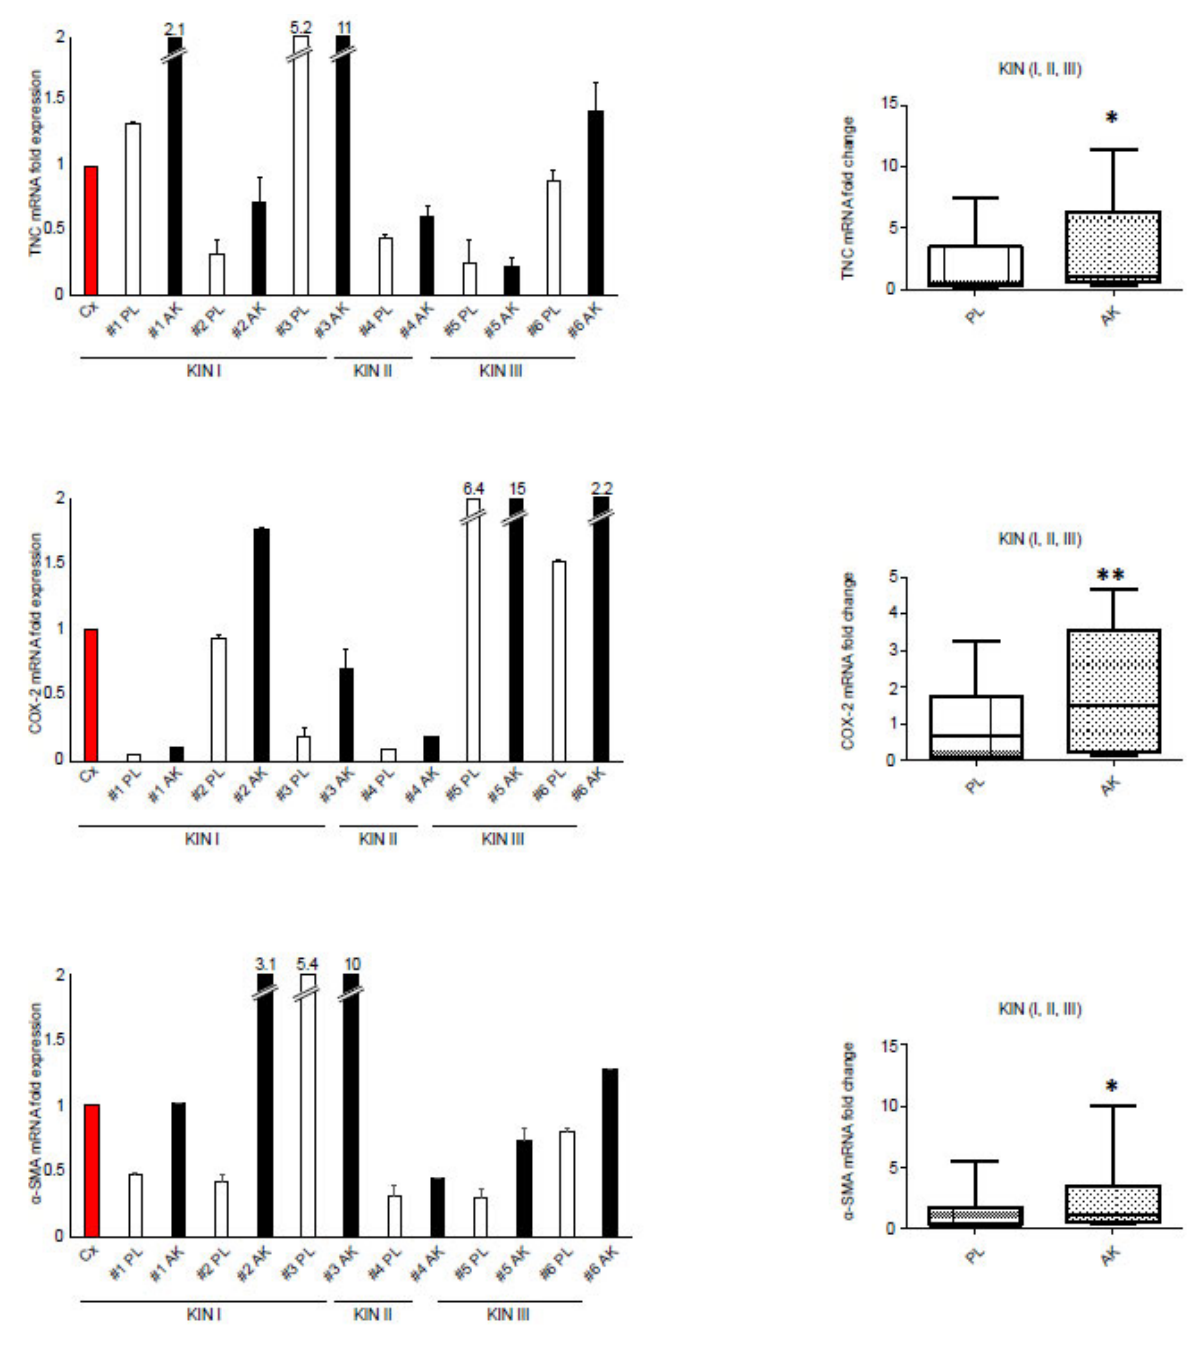
Figure 2. Expression of CAF genes in the dermal portion of KIN I, KIN II, and KIN III samples. TNC, COX-2, α -SMA mRNA levels were evaluated by real-time RT-PCR in KIN I, KIN II, and KIN III samples (PL—perilesional samples, white bars; AK—lesional samples, black bars) and normalized with respect to the mean of all the perilesional values (Cx, red bar), as reported in the graph. Results are expressed as mean ± standard deviation (SD). Statistical analysis of relative expression rates of KIN I + KIN II + KIN III AK versus KIN + KIN I + KIN III PL samples was performed using Wilcoxon rank-sum test, and significance levels were defined as p < 0.05. * p < 0.05; ** p < 0.01 versus the corresponding PL samples.